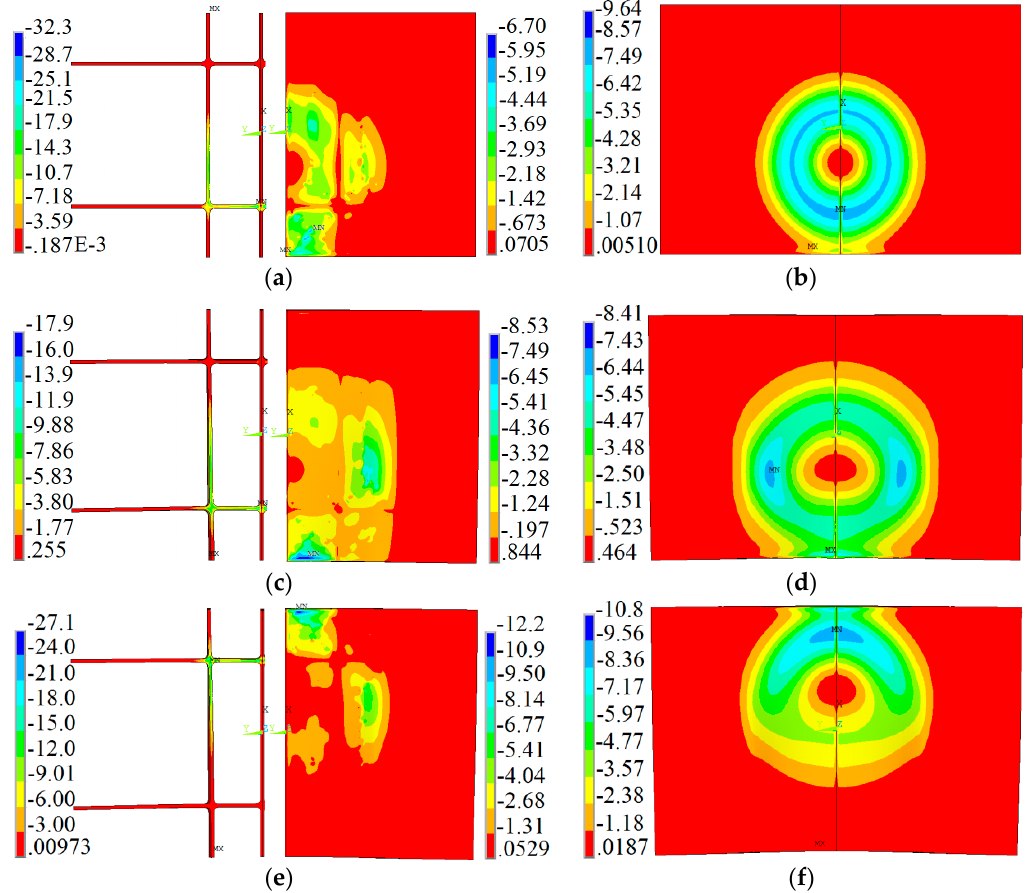
Figure 5. Electromagnetic force (N) distribution in the SP (Left, ribs and web) and FP (Right) during